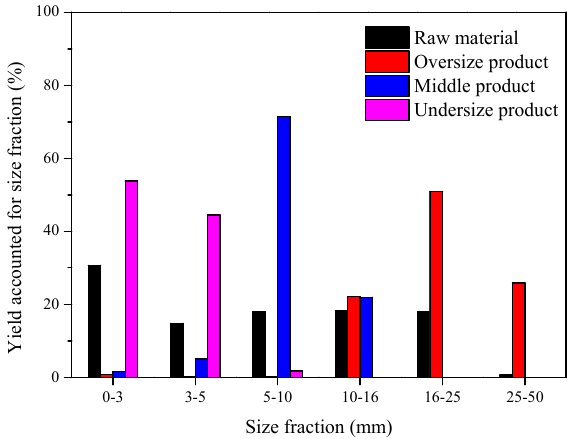
Figure 16. Comparison of the screening percentages of various sizes of raw material, oversize, middle, and undersize products.